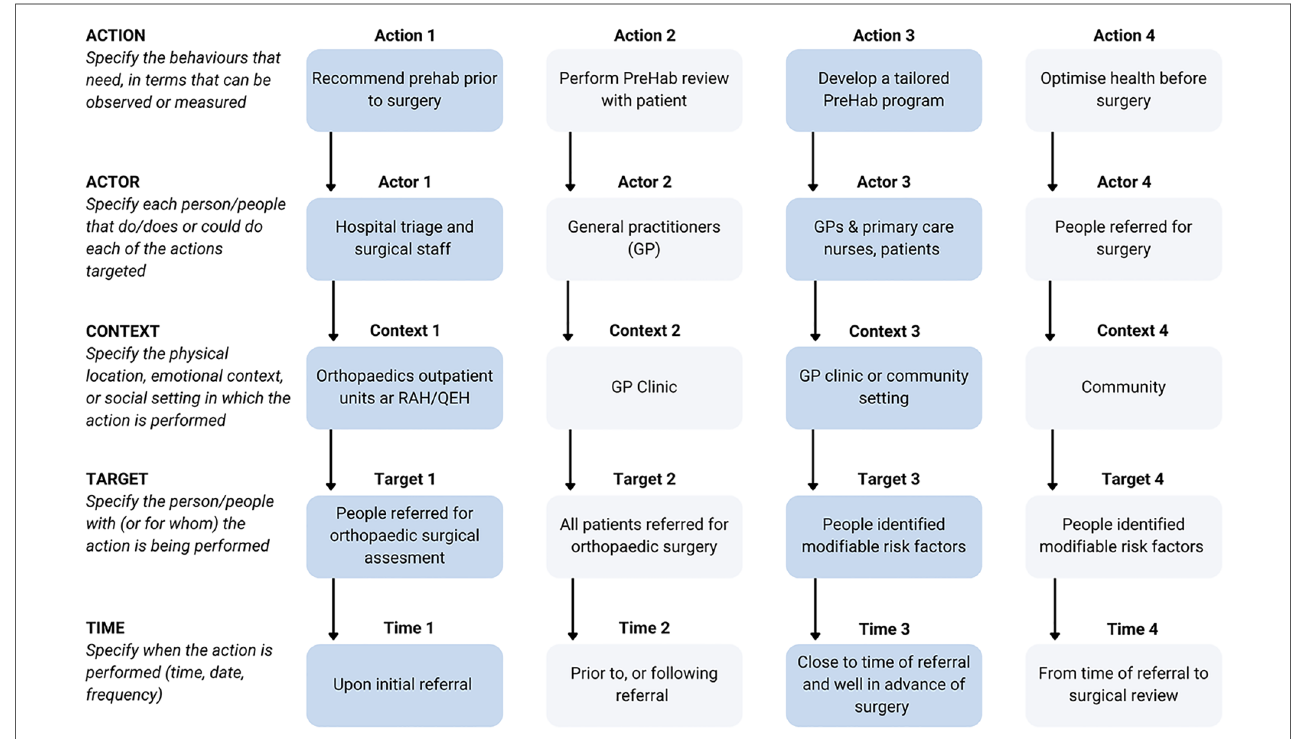
FIGURE 2 Use of the AACTT framework (14) to map the desired behavioral change objectives of the My PreHab Program